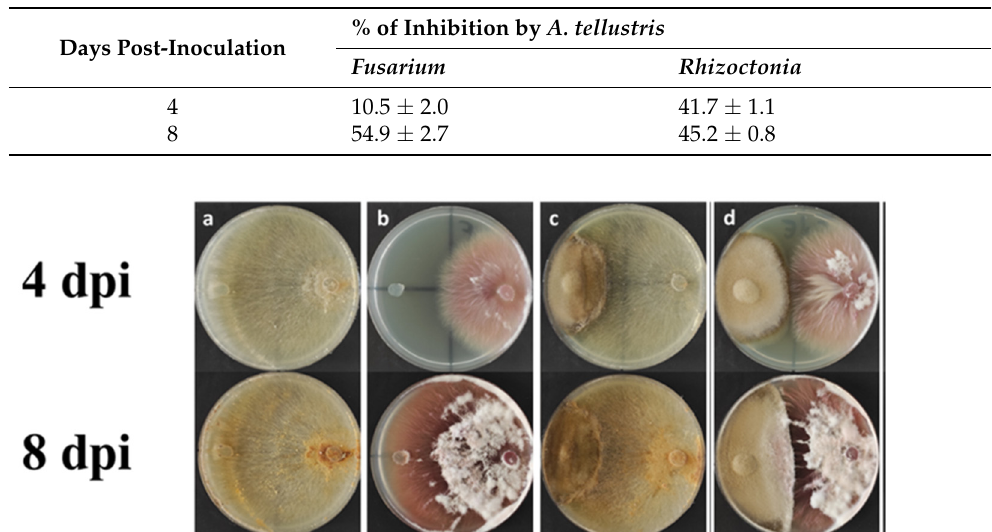
Figure 7. Representative pictures of the antagonistic activity assay via dual culture method at 4 and 8 days post-inoculation (dpi), respectively. ( a , b ) Control plates of R. solani and F. oxysporum , respectively; ( c ) dual culture assay of A. telluris and R. solani ; ( d ) dual culture assay of A. telluris and F. oxysporum .